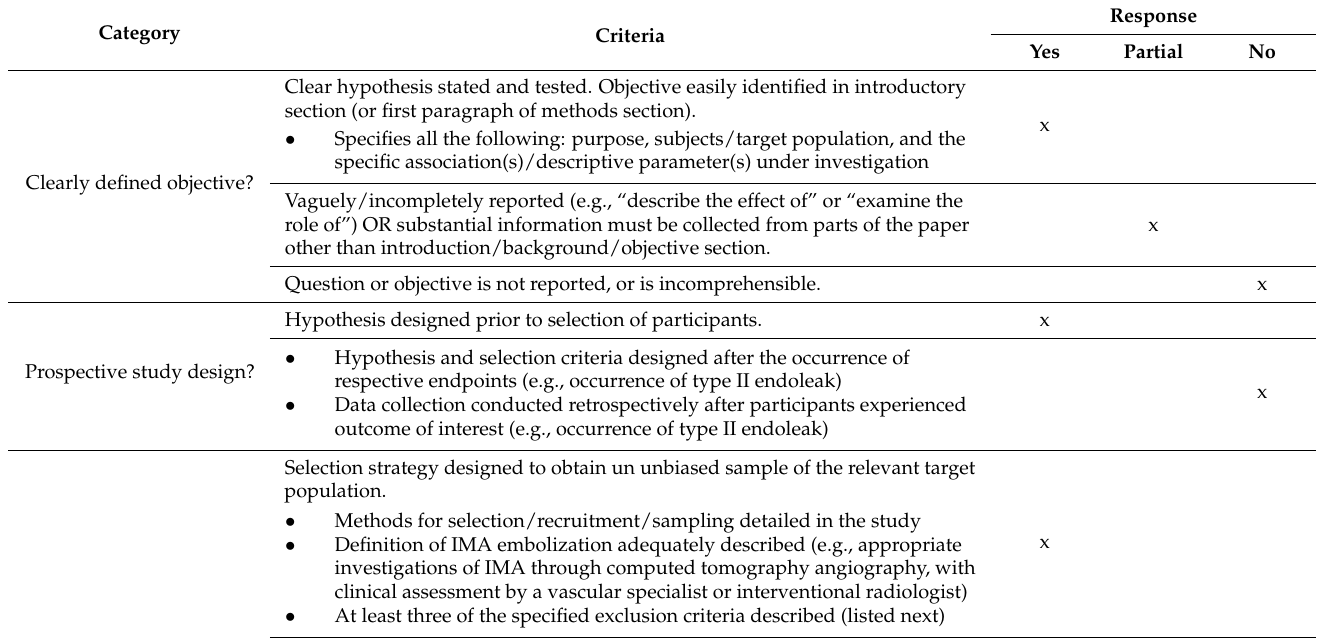
Table 1. Criteria used to perform the methodologic quality